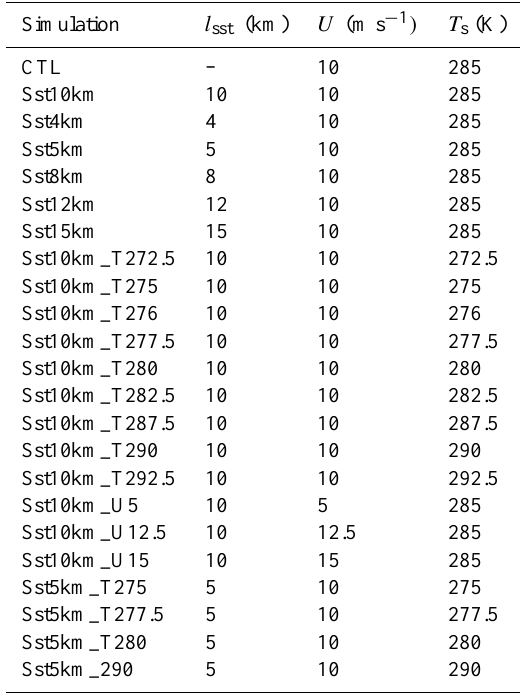
Table 1. Summary of WRF simulations